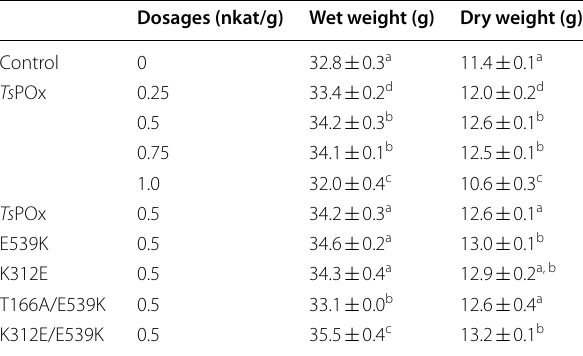
Table 3 Effect of Ts POx and its mutants on the wheat flour gluten